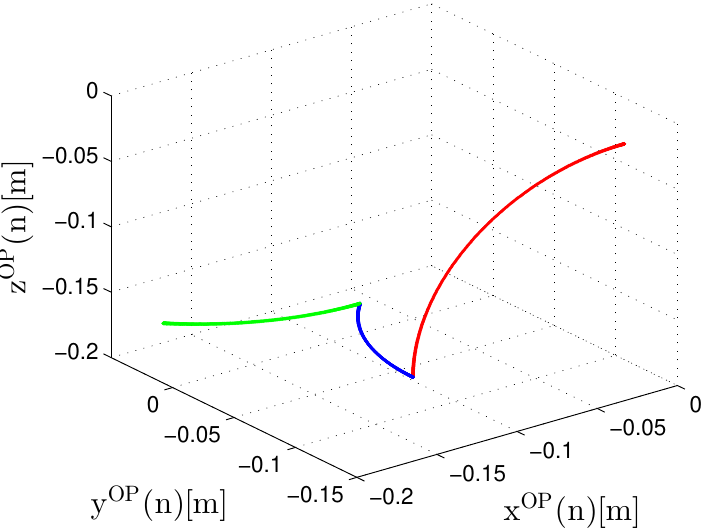
Figure 32. Trajectory used to validate hardware